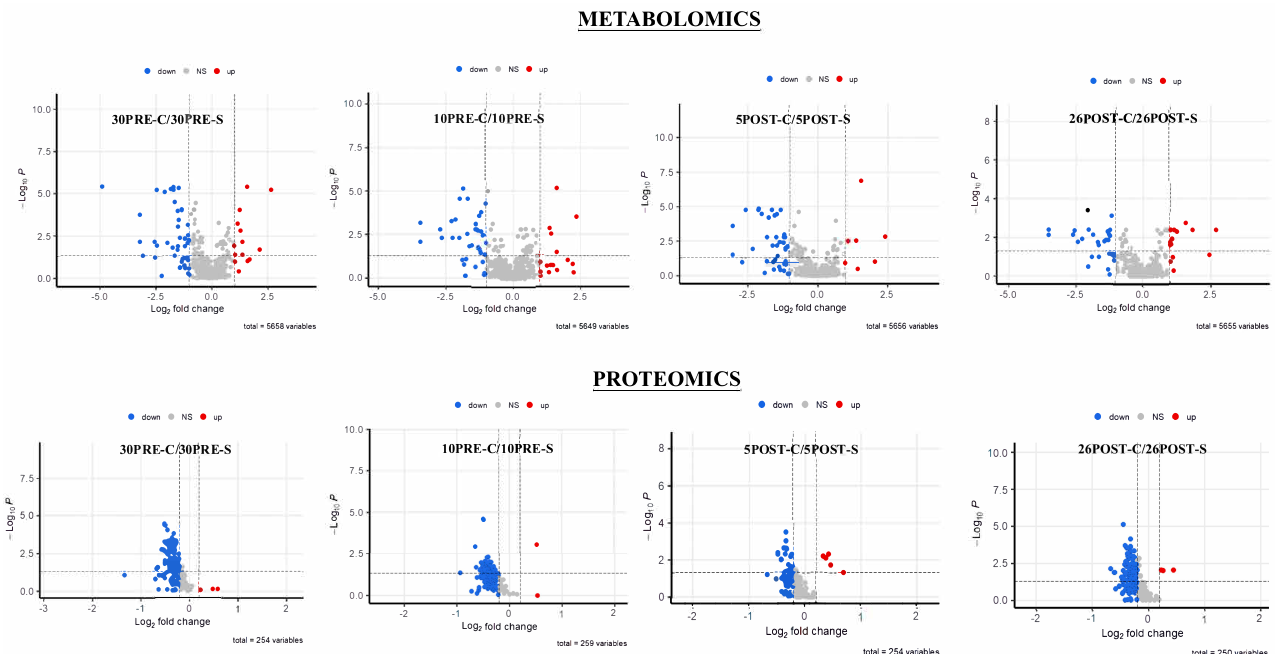
Figure 2. The combined data of serum metabolomics and proteomic profiles were separated in a sparse partial least squares discriminant analysis in four different comparisons.